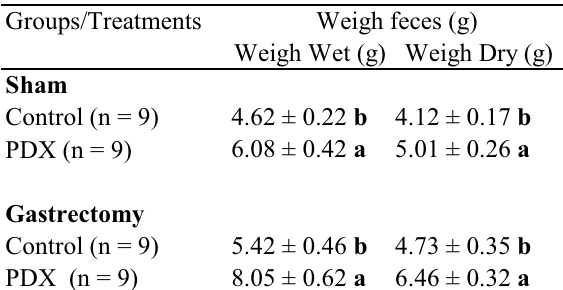
TABLE 3 - Weight wet and dry of the feces (g) collected in 3 times (15, 35 and 55 days) of the experimental phase, for three days each period of the groups sham-operated and rats with gastrectomy fed diets with polydextrose (PDX) or